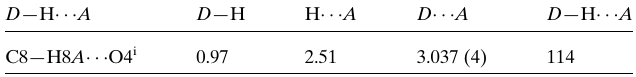
Table 2 Hydrogen-bond geometry (A˚ , (cid:2)